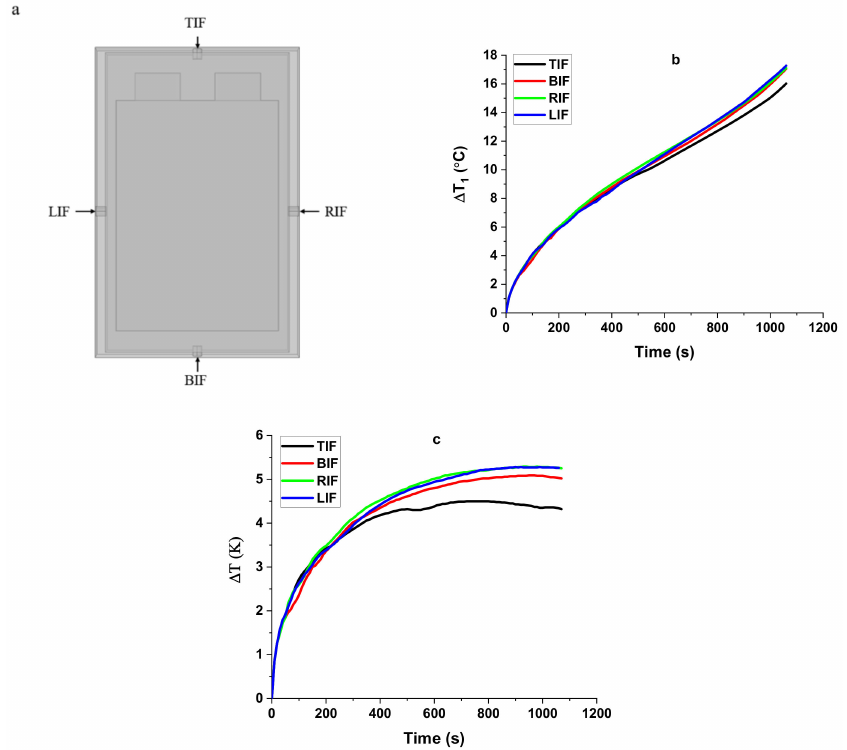
Figure 9. ( a ) Schematic of top-inlet flow (TIF), the bottom-inlet flow (BIF), the right-inlet flow (RIF), and the left-inlet flow (LIF), and effects of flow direction on ( b ) ∆ T 1 and ( c ) ∆